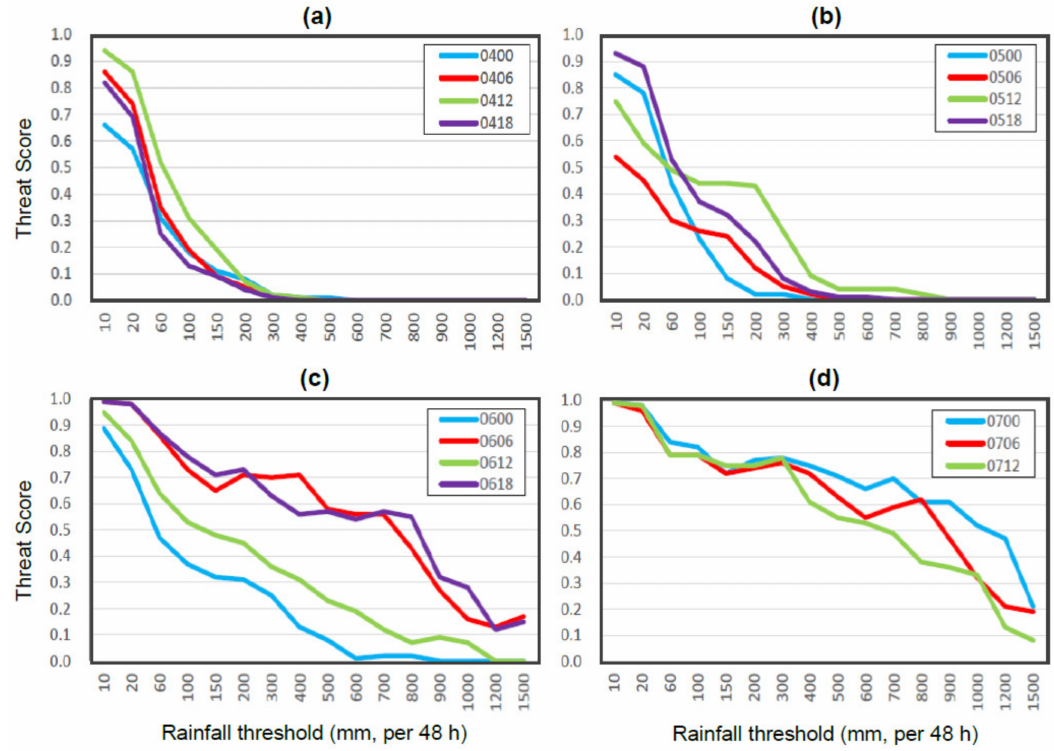
Figure 5. Threat scores (TSs) of 48-h QPFs over Taiwan, targeted for the 48-h period from 1200 UTC 7 to 1200 UTC 9 August during TY Morakot (2009), from six-hourly time-lagged ensemble hind- casts made during ( a ) 4 August, ( b ) 5 August, ( c ) 6 August, and ( d ) 7 August (to 1200 UTC only),